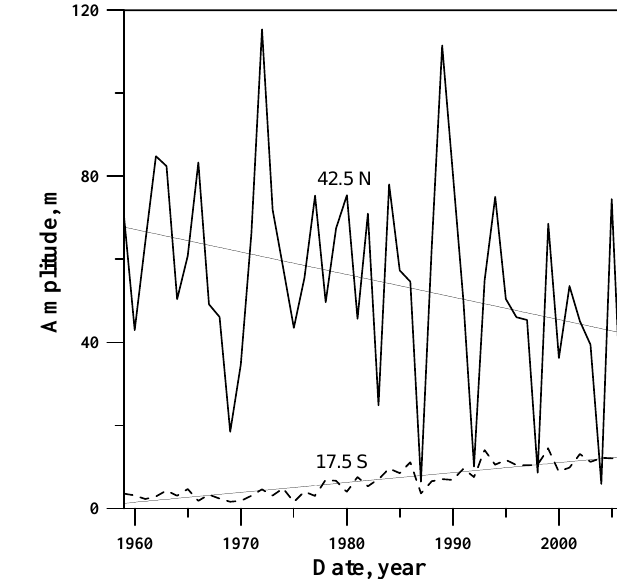
Fig. 13. The same as in Fig. 12, but for the SPW2 at 42.5N latitudes (solide line) and 17.5S latitudes (dashed